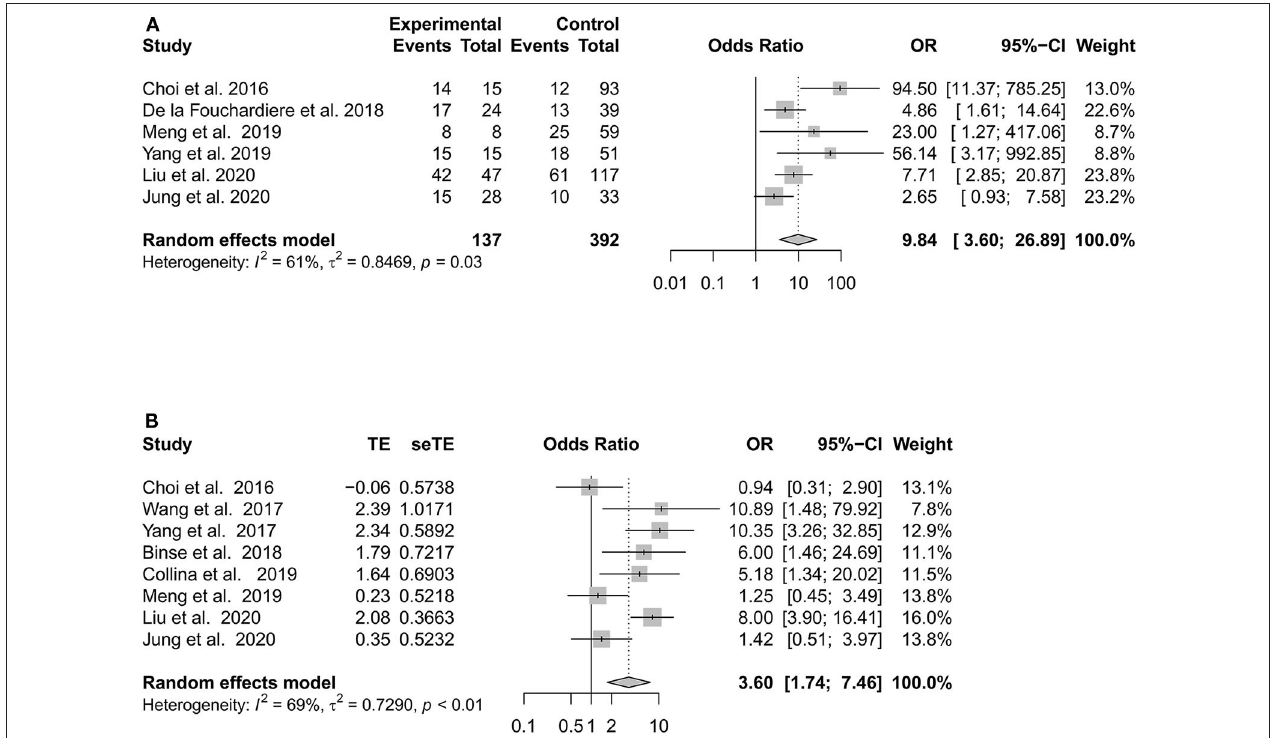
FIGURE 3 | Forest plot detailing the odds ratios with 95% confidence intervals for the effect of TERT promoter mutation (A) and BRAF V 600 E mutation (B)